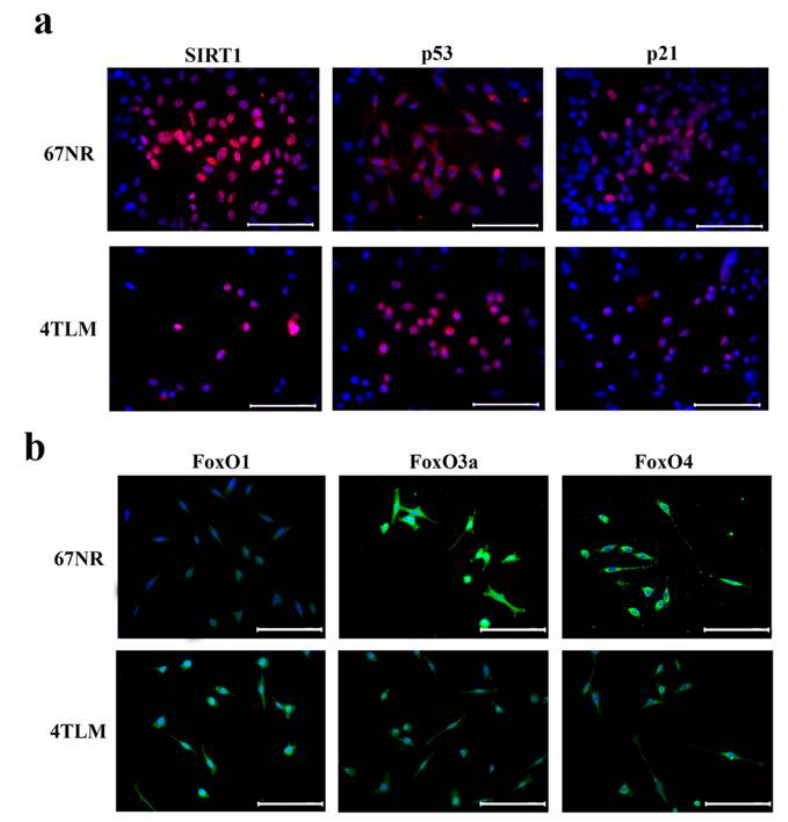
the nucleus in both 67NR and 4TLM cells but less so in 4TLM compared to 67NR cells (Figure 1a). FoxO1, FoxO3a and FoxO4 exhibited distinct cytoplasmic expressions in 4TLM and 67NR cell lines (Figure 1b). FoxO1 expression was higher in 4TLM cells compared to 67NR cells, and the expression FoxO3 and FoxO4 was higher in 67NR cells compared to 4TLM cells.